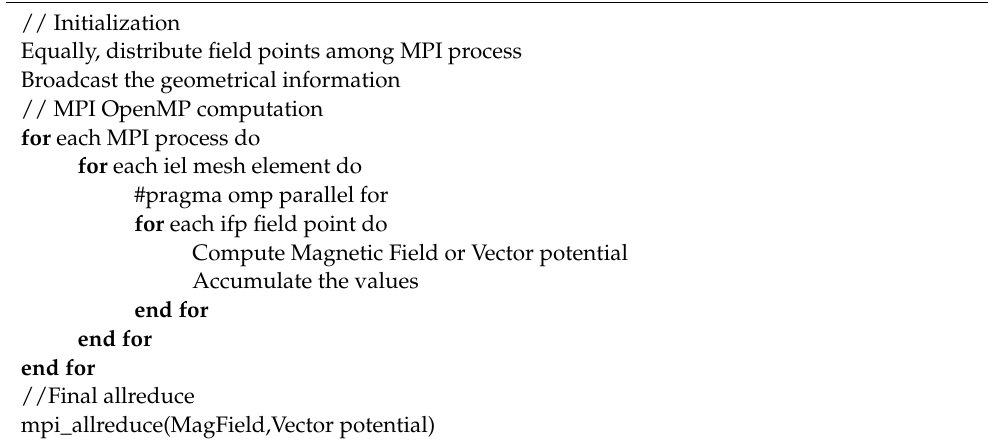
Algorithm 6 Evaluation of Q matrix, hybrid OpenMP-MPI Approach